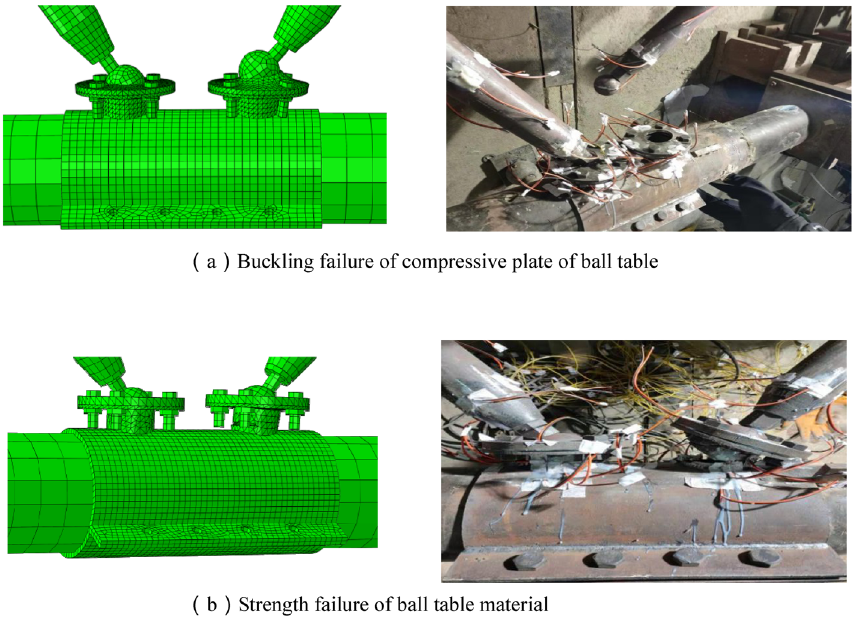
Figure 16. Comparison of failure modes (ABAQUS 2020 https:// www. 3ds. com/ produ cts- servi ces/ simul ia/).